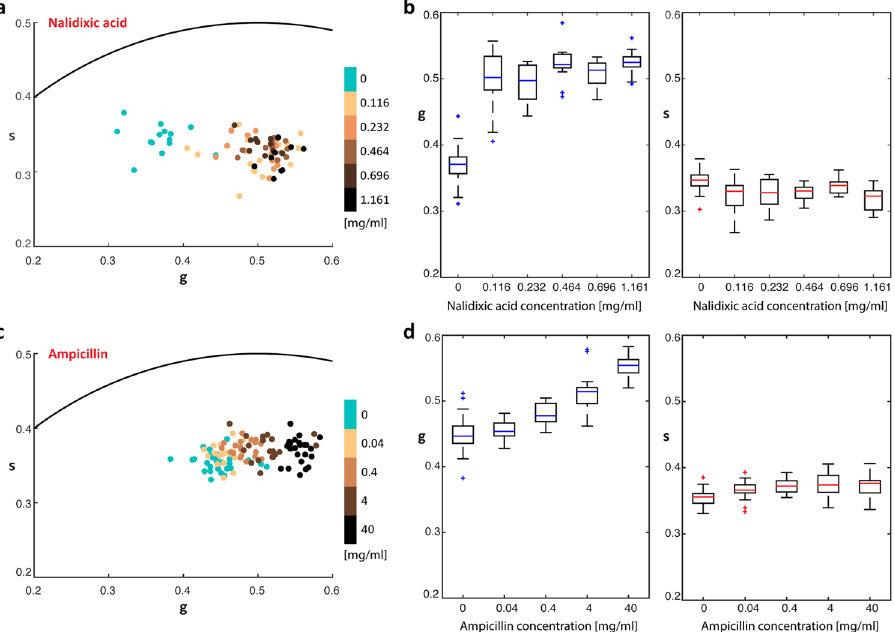
Figure 2. Bacterial phasor response to bacteriostatic and bactericidal antibiotic treatment. ( a ) Bacterial phasor of E. coli control culture (cyan) and culture treated with increasing concentrations of a bacteriostatic antibiotic, nalidixic acid (light to dark brown). ( b ) Distribution of g and s within populations of cells at each concentration of nalidixic acid. ( c ) Bacterial phasor of E. coli control culture (cyan) and culture treated with increasing concentrations of bactericidal antibiotic, ampicillin (light to dark brown). ( d ) Distribution of g and s within populations of cells at each concentration of